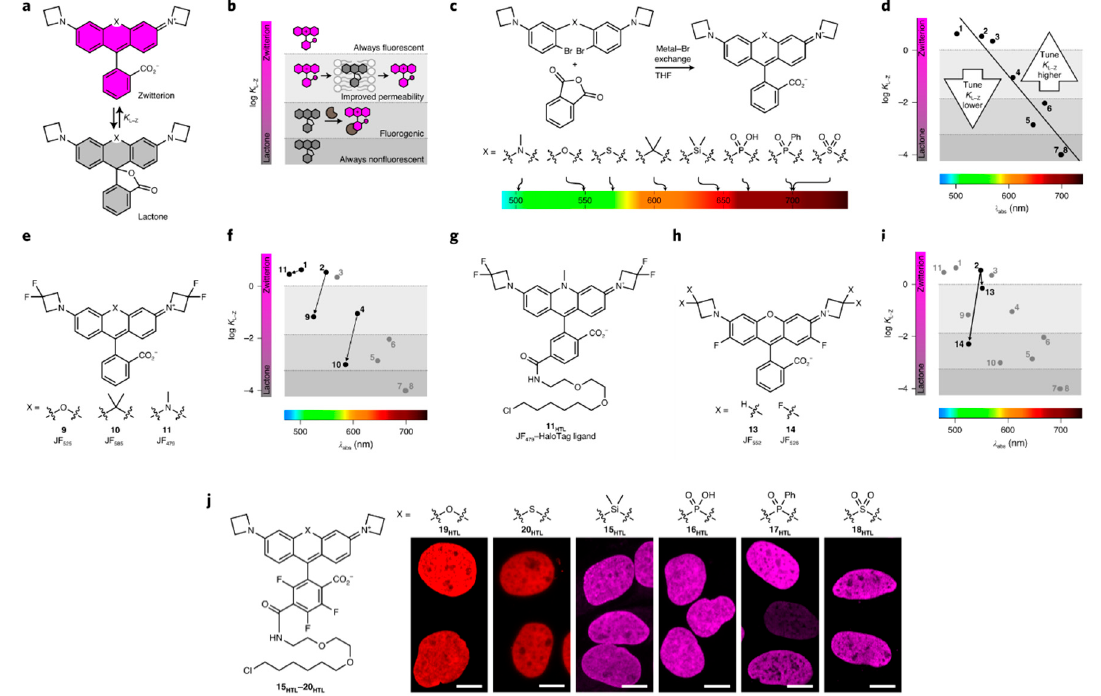
Figure 24. General method to optimize and functionalize red-shifted rhodamine dyes: ( a ) the lactone–zwitterion equilibrium of JF rhodamine dyes and the equilibrium constant K L–Z ; ( b ) Phenomenological plot categorizing the properties of different dyes based on K L–Z ; ( c ) Synthesis, structures and λ exc of dyes 1–8; ( d ) Plot of K L–Z versus λ exc for dyes 1–8 and general tuning strategies for dyes with short or long λ exc ; ( e ) Structures of dyes 9–11; f, Plot of K L–Z versus λ exc showing decreased K L–Z for dyes 9–11; ( g ) Structure of JF 479 –Halotag ligand (11 HTL ); ( h ), Structures of dyes 13–14; ( i ) Plot of K L–Z versus λ exc showing decreased K L–Z for dyes 13–14; ( j ) High-magnification images of fixed U2OS cell nuclei expressing Halotag–histone H2B and labeled with 15 HTL – 20 HT L . Adapted by permission from Nature: Springer, Nature Methods [51] Copyright (2020). Scale bars = 10 µm.